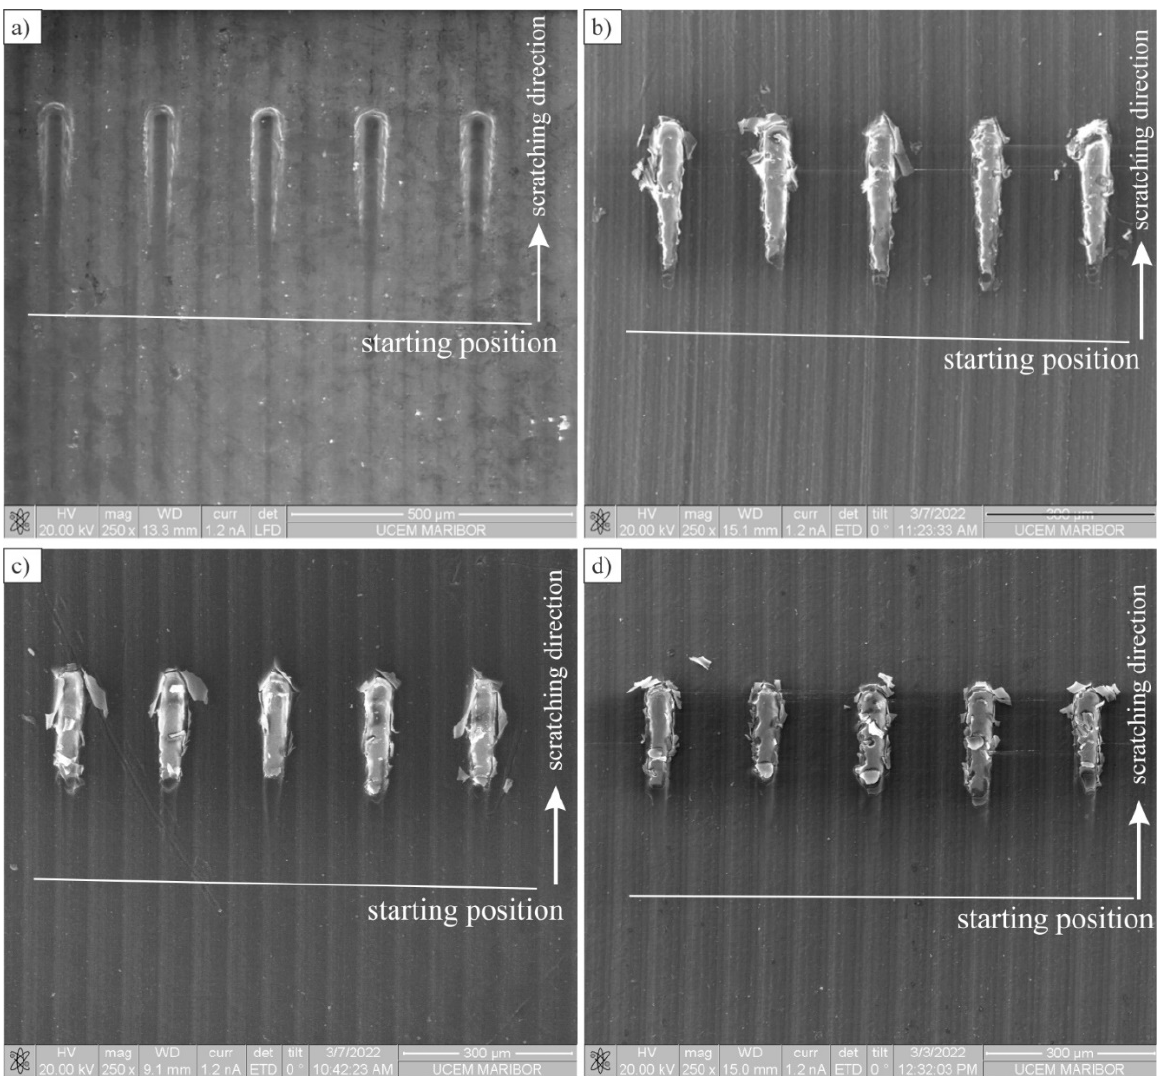
Figure 6. Backscattered electron micrographs of scratches (The white line indicates the position at which scratch tests started): ( a ) Uncoated POM, ( b ) One coating layer, ( c ) Three coating layers, ( d ) Five coating layers.